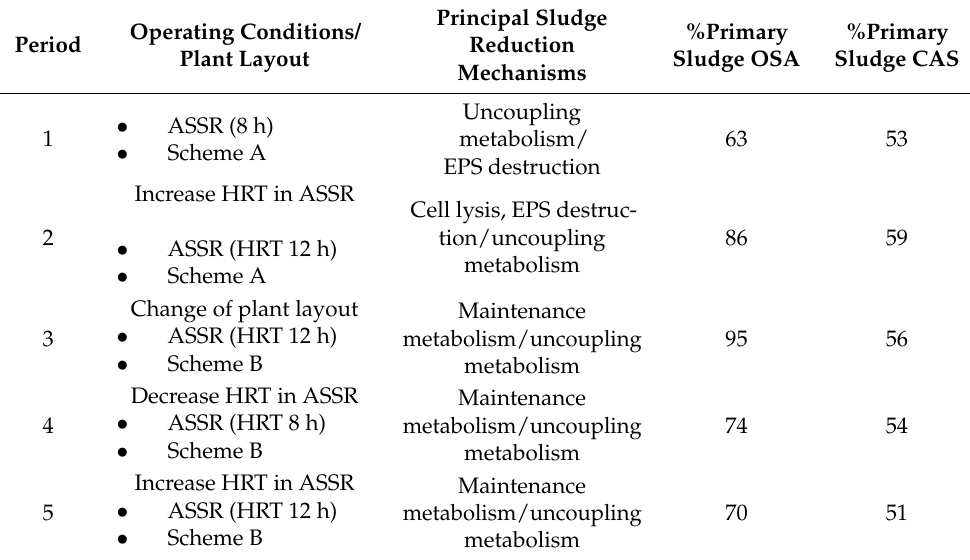
Table 2. Summary of the main possible mechanisms involved in excess sludge minimization during each period, and percentage of primary sludge in the sludge produced by OSA and